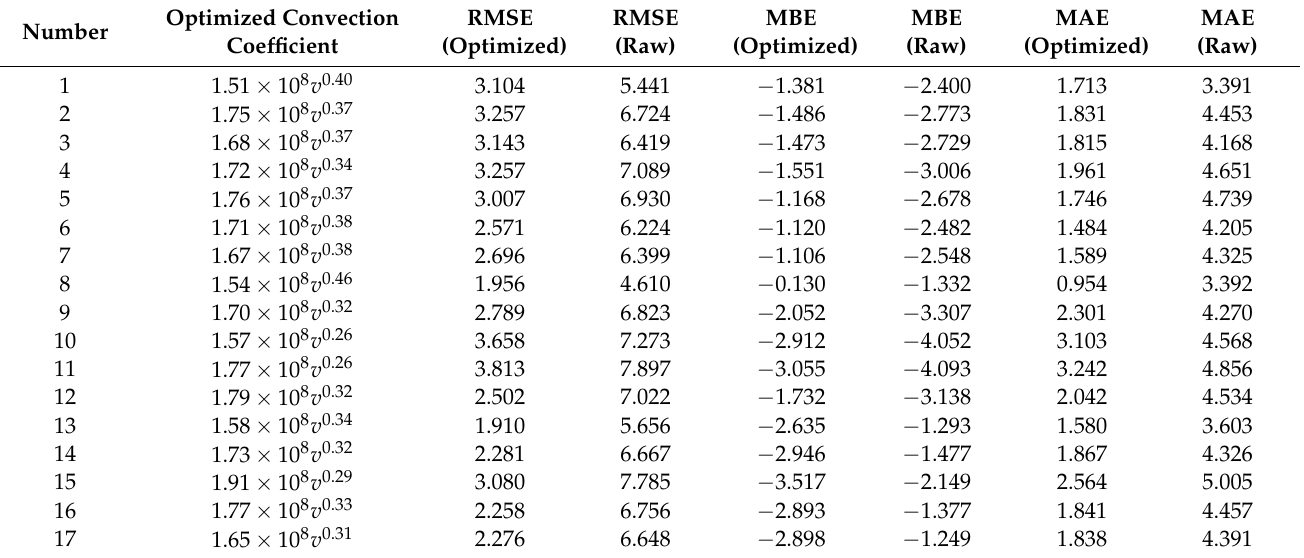
Table A4. Adapted convection coefficient (where v is the wind velocity (m s − 1 )) and root mean square error (RMSE), mean bias error (MBE), and mean absolute error (MAE) for the optimized and raw values of the tested mean radiant temperature sensors